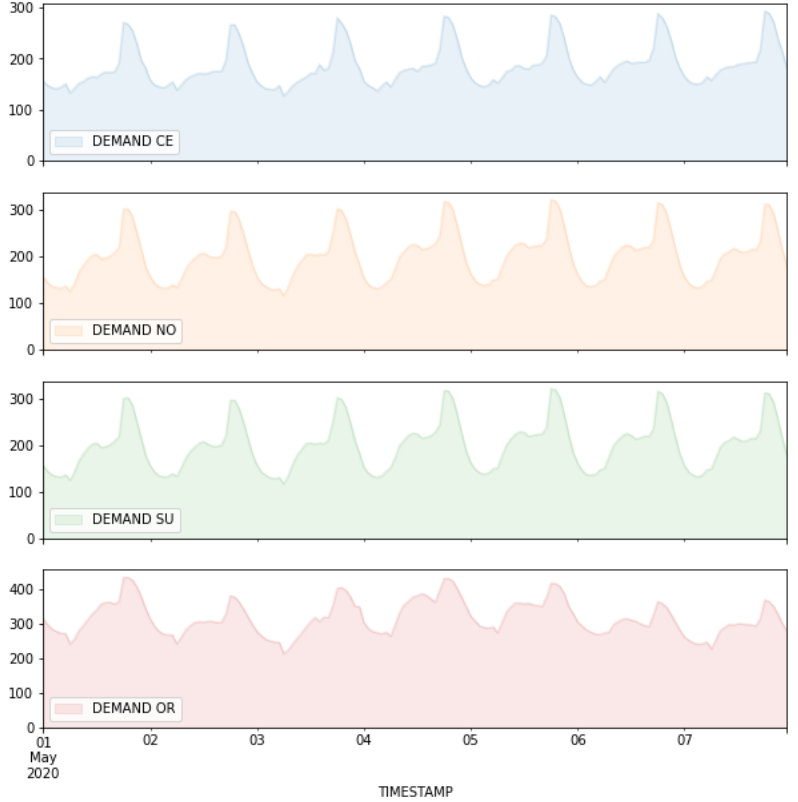
Figure 4. Load curves for all four zones (1–7 May